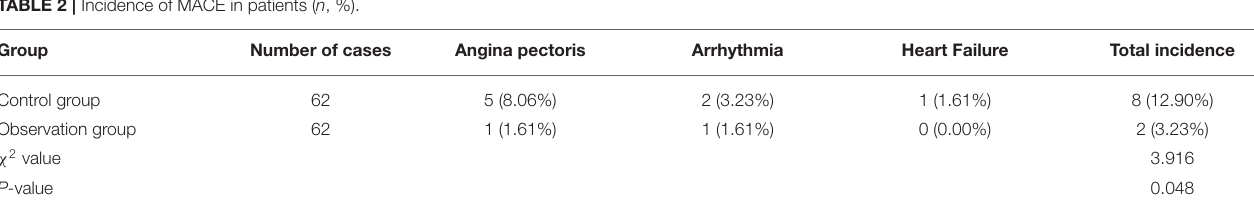
TABLE 2 | Incidence of MACE in patients ( n ,